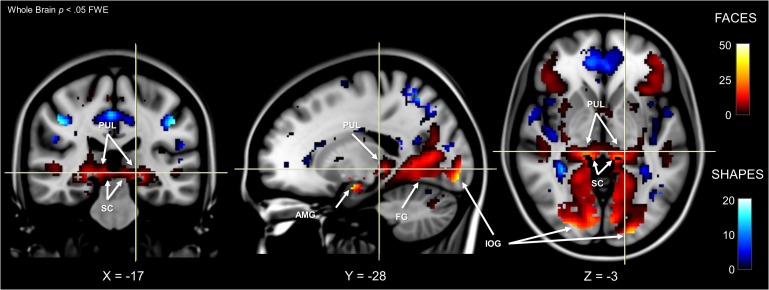
Whole-brain fMRI activation for faces and shapes.Face activation is shown by hot colours and shape activation is shown by cool colours. MNI coordinates are shown at the bottom. Labels indicate significant (p < 0.05, whole brain FWE) activation in the superior colliculus (SC), pulvinar (PUL), amygdala (AMG), inferior occipital gyrus (IOG), and fusiform gyrus (FG). Results are overlayed on an averaged MNI152 T1 template.